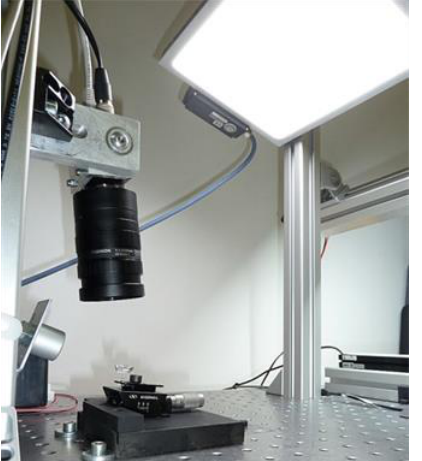
Figure 2. Image acquisition setup. The camera and an LED panel were positioned in such a way that the light specularly reflected by the component falls directly in the direction of the camera axis. This provided the best defect representation in the images.